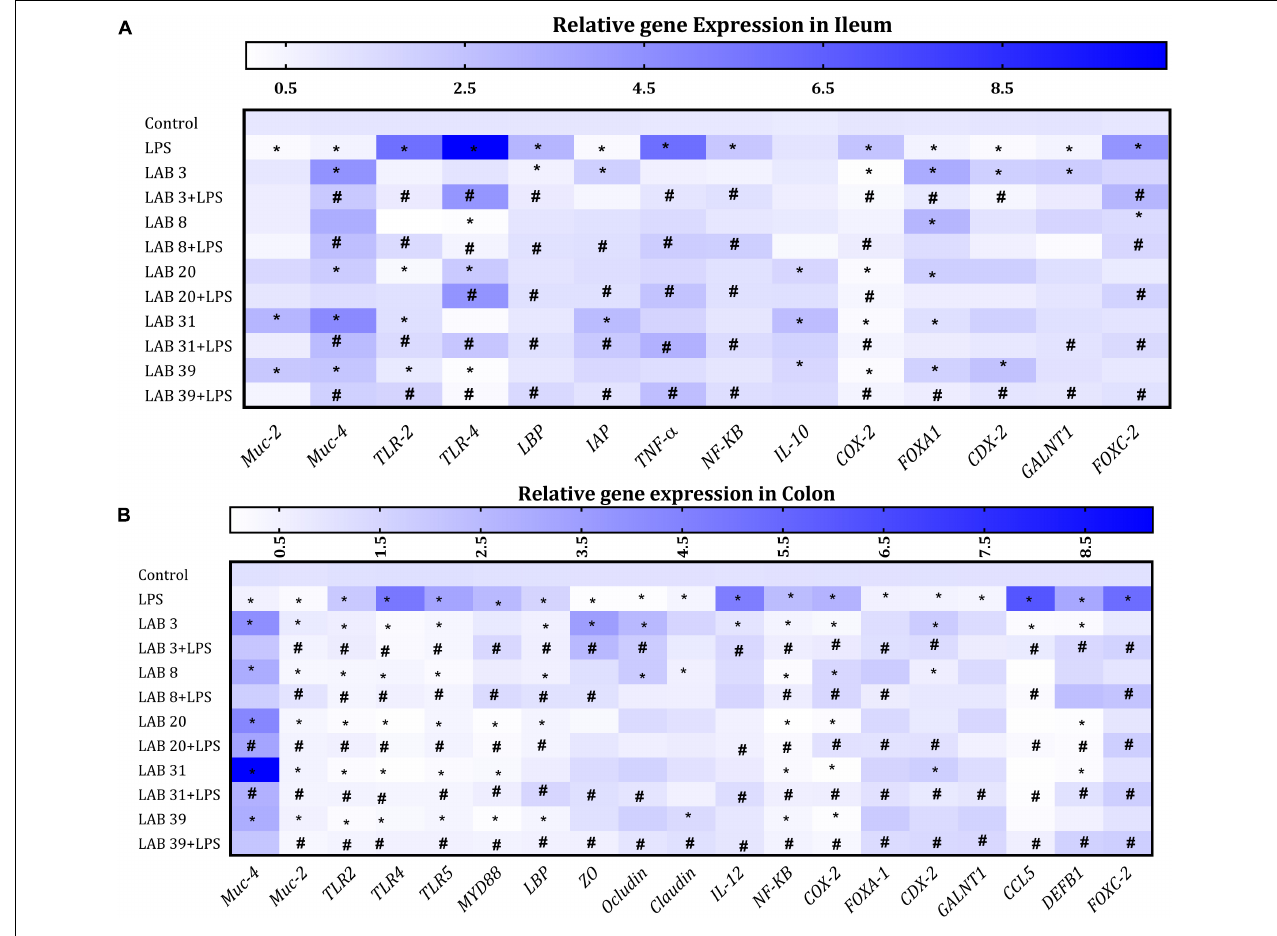
FIGURE 6 | Effect of LAB supplementation on the relative gene expression in the ileum and colon: Heat map overview of genes in (A) ileum and (B) colon. Data were analyzed using one-way ANOVA with Tukey’s post hoc test ( p ≤ 0.05). *Significant relative to control; #significant relative to the LPS group ( N = 4).